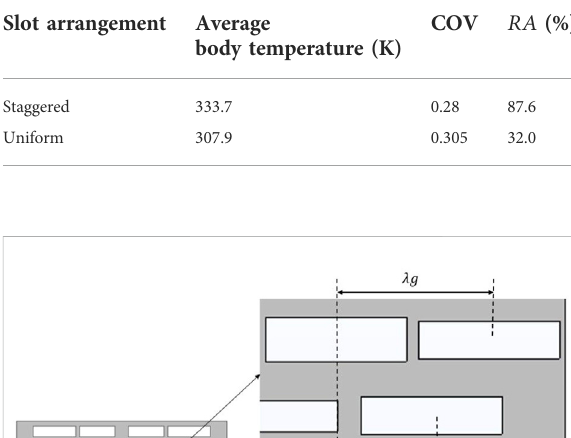
TABLE 3 Heating results of the staggered and uniform slot arrangements.